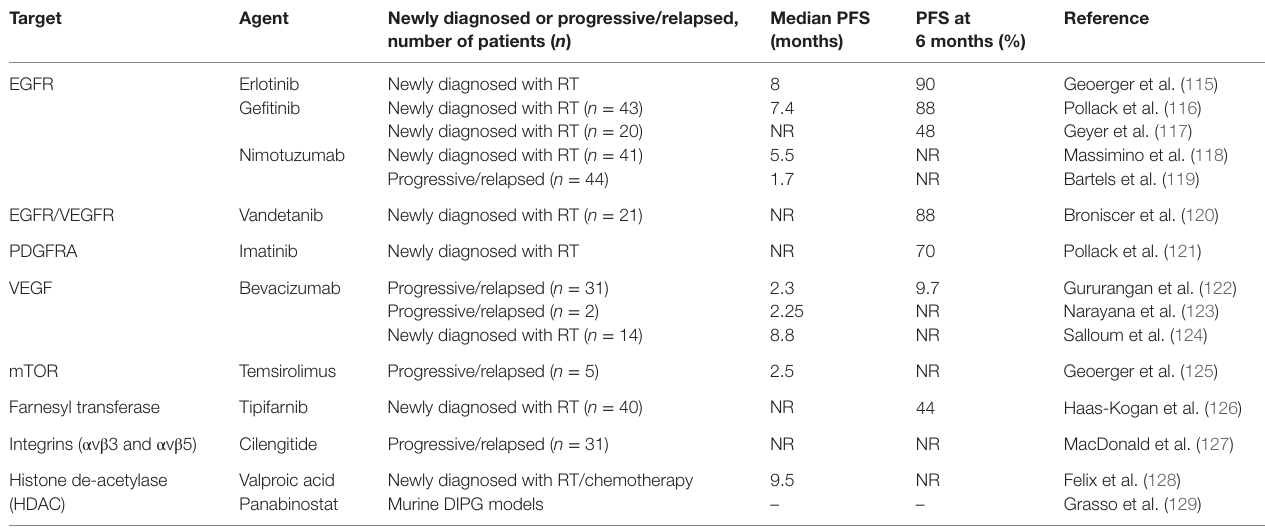
TABLe 5 | Biological/targeted therapies in